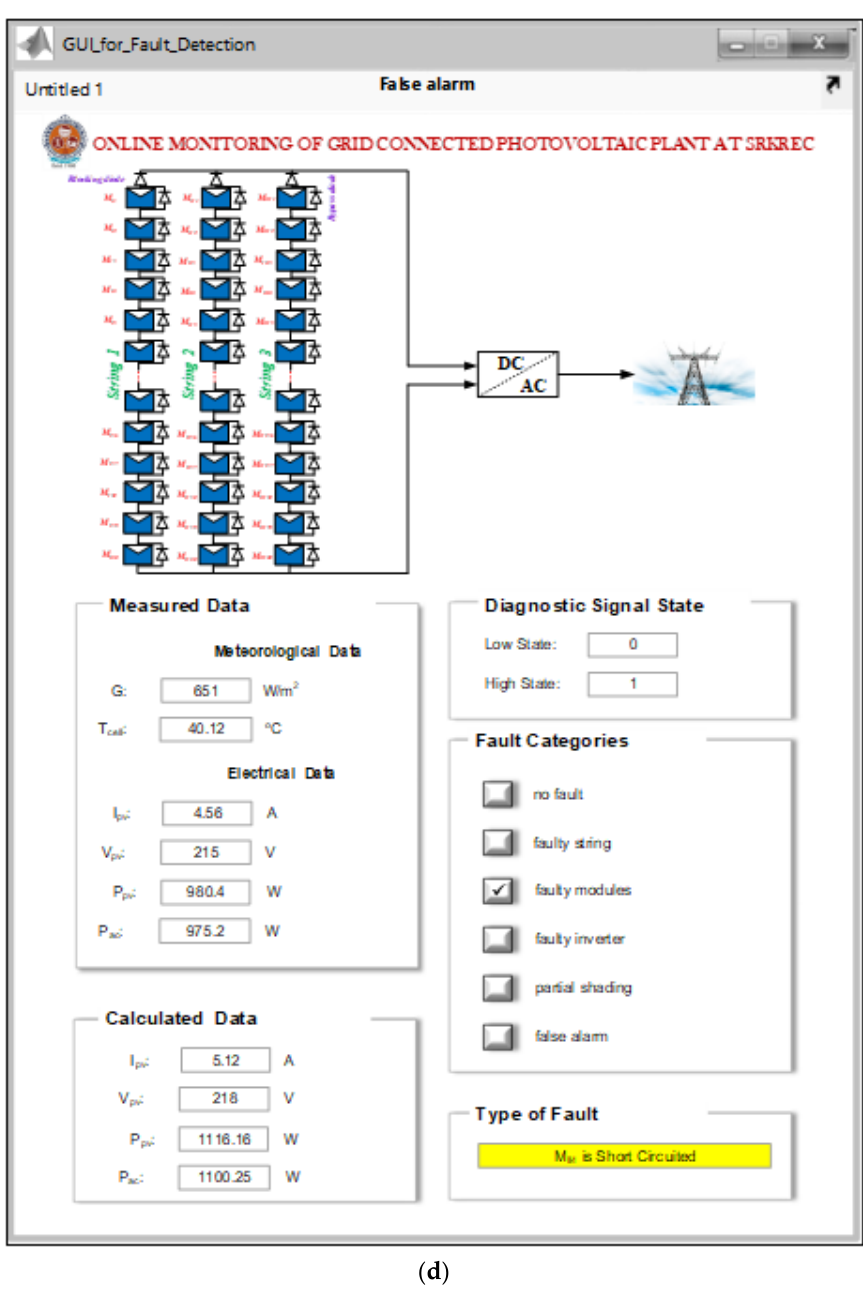
Figure 11. ( a ) Evolution of diagnostic signal during short-circuit fault condition; ( b ) measured PV current; ( c ) measured PV current; ( d ) faulty module observed in designed tool.